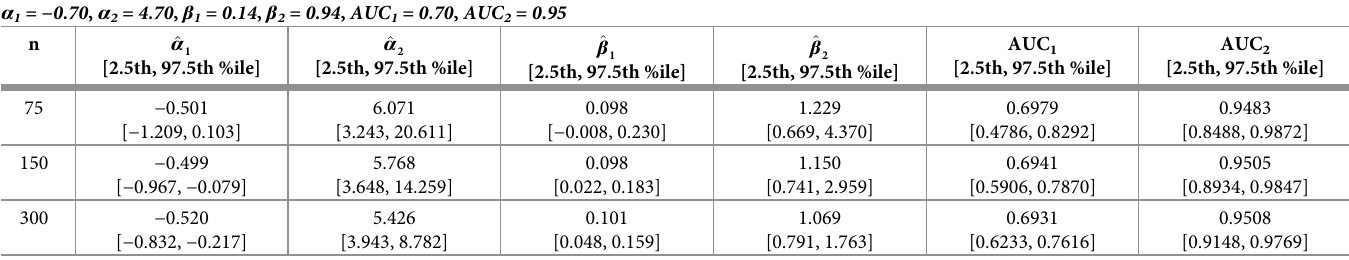
than for upper cutpoints, except for n = 150 and 300 of the NPO2 condition. For parametric cutpoints, absolute percent-bias was negligible at all sample sizes, except in the NPO2 condi- tion, where although cutpoint bias was the lowest within the condition (0.1–2.3 percent), it was slightly greater compared to other conditions (0.0–0.3 percent). Table 4. Non-proportional odds simulation: NPO2. Parameter estimates and AUCs realized from cumulative ROC curve analysis applied to 10,000 simulated datasets parameterized for non-proportional odds, AUC 1 = 0.70, and AUC 2 =